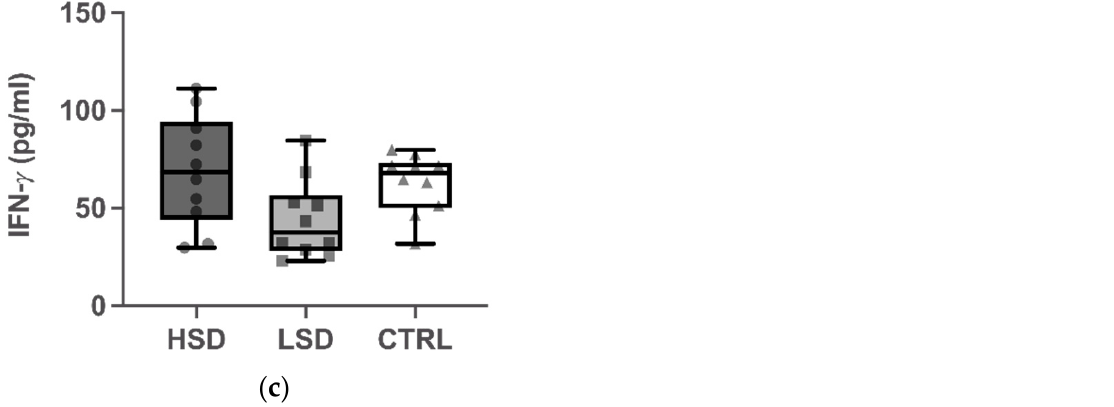
Figure 3. Effect of different concentrations of dietary sodium on the production of cytokines by splenocytes. Splenocytes were isolated from the spleens after OVA challenge and incubated in culture medium containing fetal bovine serum (FBS) and OVA for 1 to 3 days. Interleukin (IL)-4 ( a ), IL-10 ( b ), and interferon- γ (IFN- γ ) ( c ) were measured by sandwich ELISA. Data are expressed as box-and-whisker plots with individual data points. The boxes represent the inner quartiles value range with the median indicated as black line. The whiskers represent minimum to maximum interval. * p < 0.05 and ** p < 0.01. High-salt diet: HSD, Low-salt diet: LSD, Control diet: CTRL.